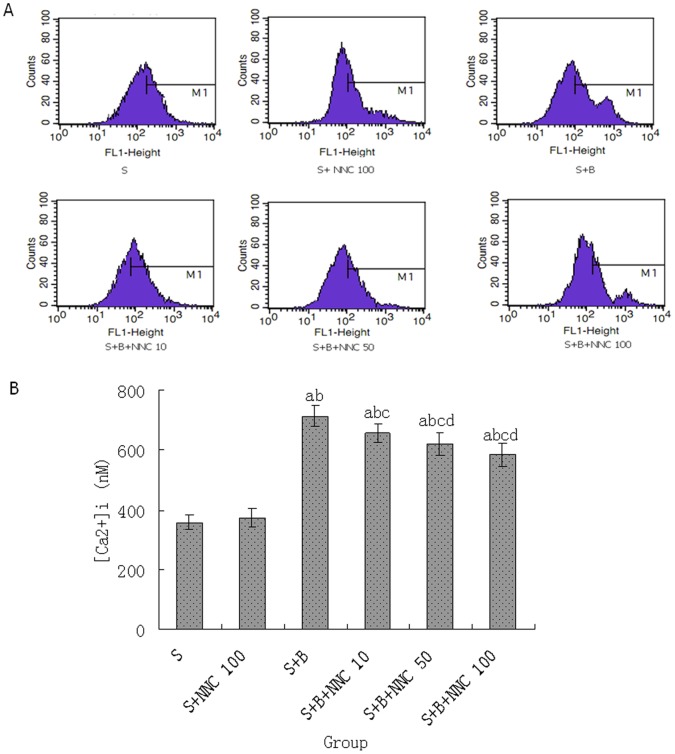
Bupivacaine treatment leads to an increase in cytosolic Ca2+ ([Ca2+]i).SH-SY5Y cells were either pretreated with the indicated concentrations of NNC 55-0396 dihydrochloride or left untreated prior to 1 mM bupivaine treatment for 24 h. [Ca2+]i levels were measured by Quest Fluo-8 AM ester (mean±SD, n = 6)). A: Representative image of Quest Fluo-8 AM ester flow cytometry analysis. B: [Ca2+]i levels in the different treatment groups. aP<0.05 vs. S group; bP<0.05 vs. S+NNC 100 group; cP<0.05 vs. S+B group; dP<0.05 vs. S+B+NNC 10 group.